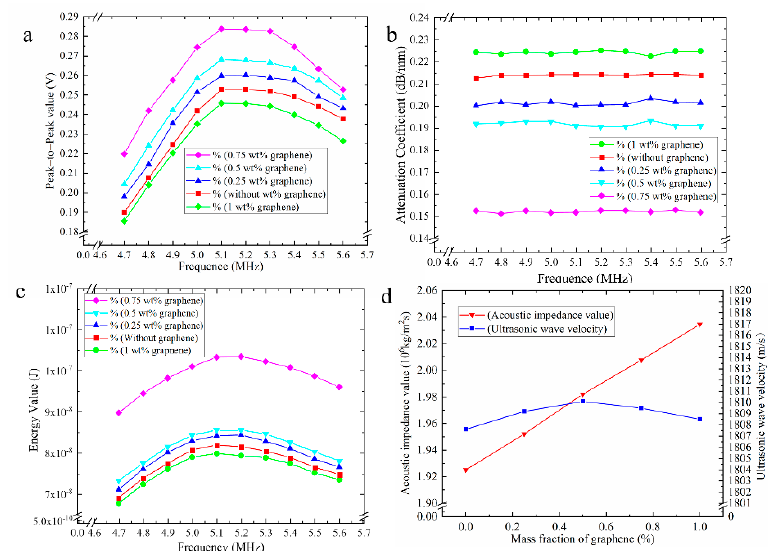
Figure 4. ( a ) Peak-to-peak values, ( b ) Attenuation coefficient, ( c ) Energy value of the received signal with hydrogel-graphene composite coupling agent. ( d ) Acoustic impedance values and ultrasonic wave velocity of the hydrogel–graphene composite coupling agent with the mass fraction of